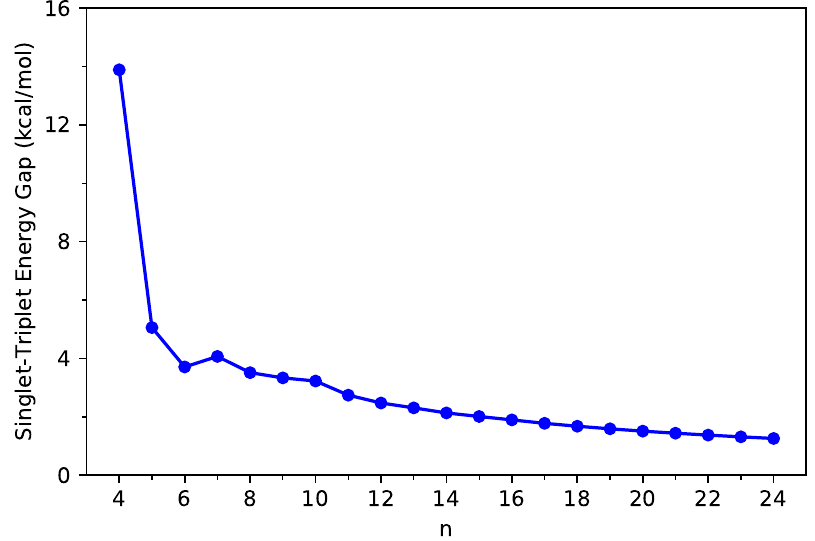
Figure 2. Singlet–triplet gap of C-Belt[ n ], computed using spin-unrestricted